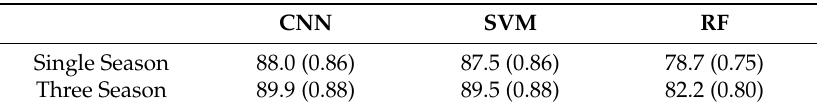
Table 2. Overall percent accuracy per classifier using single (summer) or three seasons (spring, summer, fall) of data. Kappa statistics are provided in